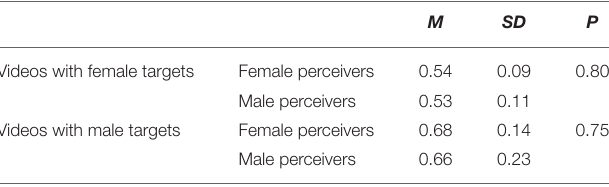
TABLE 1 | Means, standard deviations and p -values comparing EA based on perceivers’